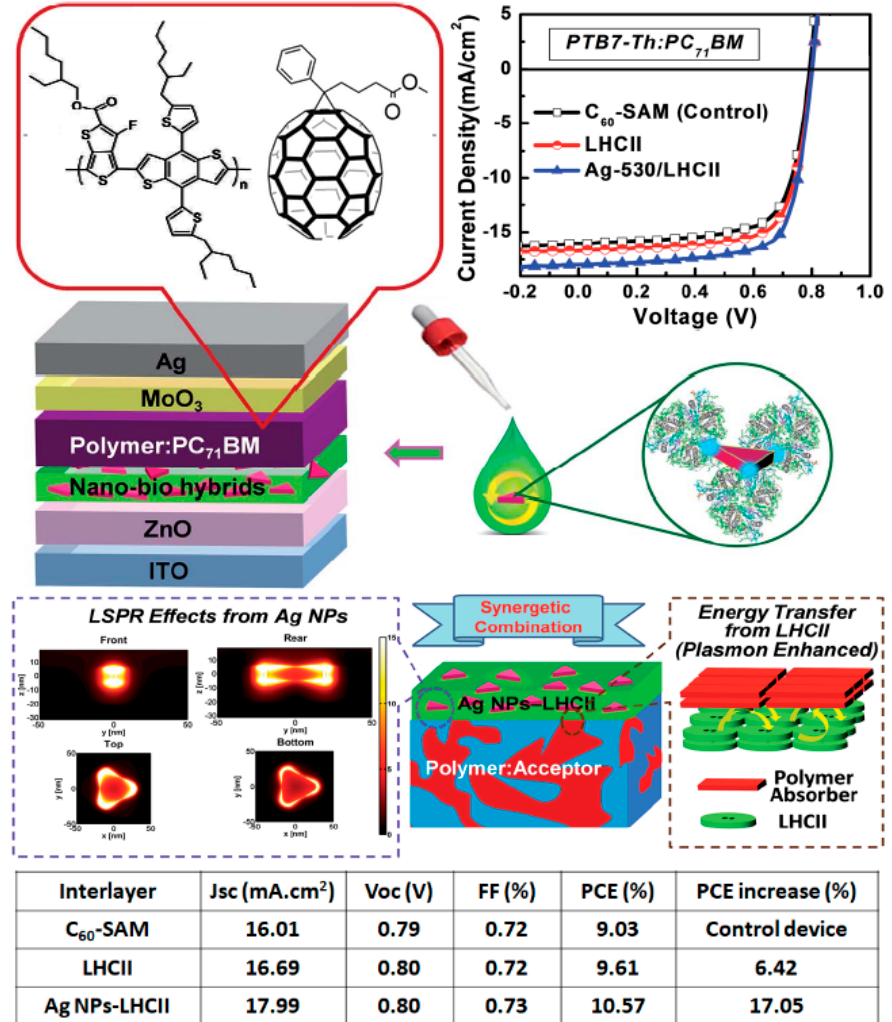
Figure 10. J – V characteristics, schematic representations of the device architecture and working principle as well as device performances of PTB7-Th:PC 71 BM OSCs employing Ag NPs-LHCII based nano-bio hybrids as interlayer material. Schematic representation of the working principle and photovoltaic performances. Reprinted with permission from Reference [55]. Copyright 2016 Royal Society of Chemistry.